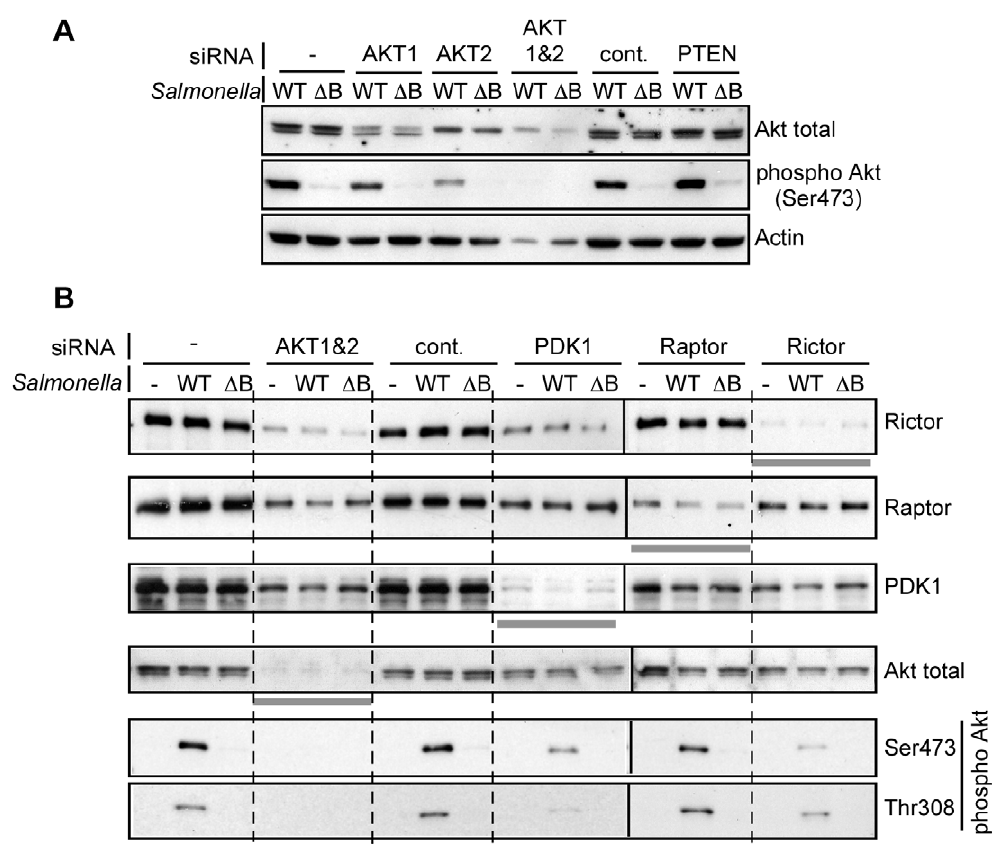
Figure 4. Both PDK1 and rictor are required for Salmonella -induced Akt phosphorylation. A and B. HeLa cells were transfected with the indicated SMART pool siRNA for 48 hr then infected with Salmonella WT or D sopB . For siRNA control SMART pool siRNA specific for AKT3 was used (cont.). After 30 min, monolayers were solubilized and processed for immunoblotting. Antibodies were used to detect phospho-Akt (Ser473 or Thr308), total Akt, PDK1, raptor, rictor or actin. Gray bars underneath the individual panels highlight the efficiency of each siRNA